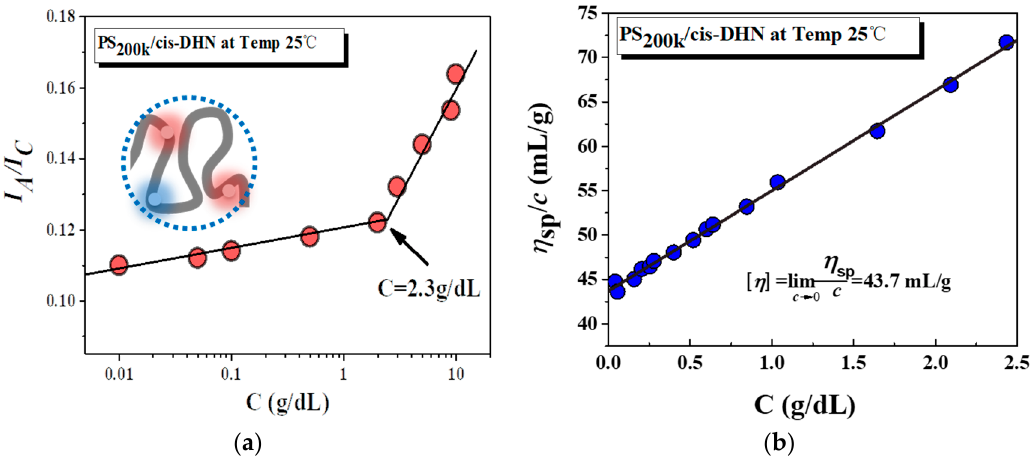
Figure 2. ( a ) The I A / I C value as a function of concentration for PS 200k doped by PS-An-Cz in cis-decalin (DHN) at 25 °C. ( b ) The reduced viscosity η sp / c as a function of concentration for PS 200k in DHN at 25 °C.